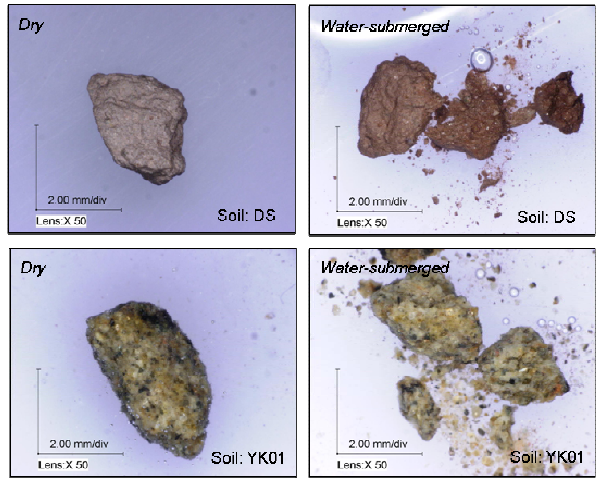
Fig. 6. Water-induced granular decomposition of crushed rocks. Figure 6. Water-induced granular decomposition of crushed rocks. 3